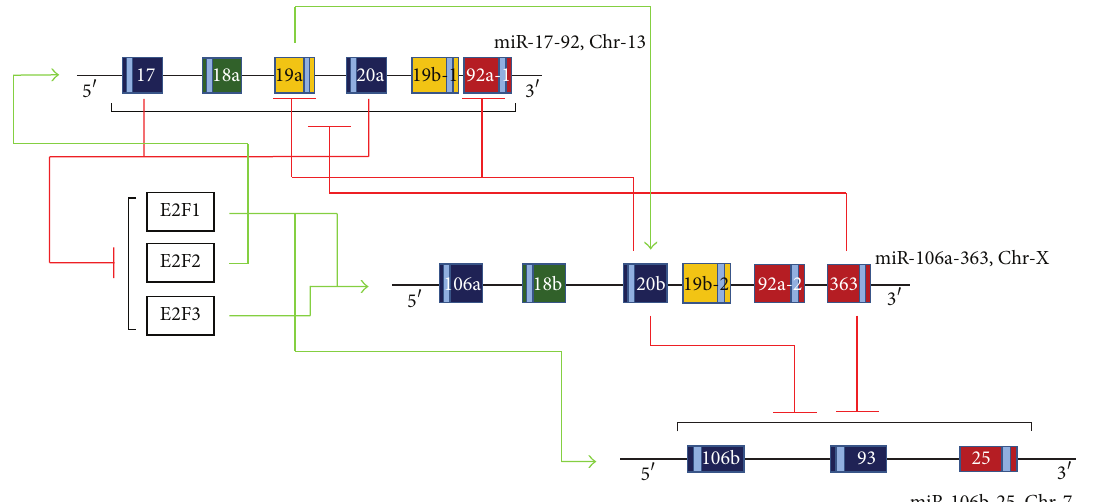
Figure 2: Schematic illustration of possible regulatory interactions between miRNAs encoded by the three paralogue clusters and with the E2F transcription factor family. Stimulatory effects are shown using green lines; inhibitory effects are shown using red